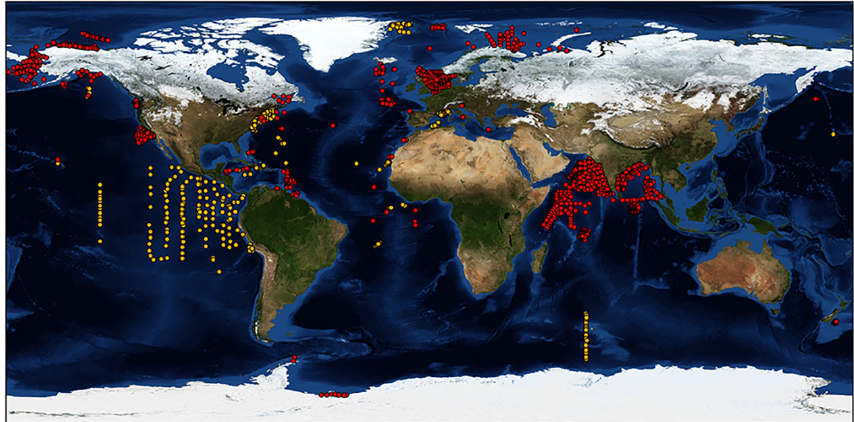
Figure 1. Map of the 6084 phytoplankton production profiles comprised in the new dataset. In orange are the profiles derived from the Ocean Productivity dataset (2214), and in red are the newly retrieved ones